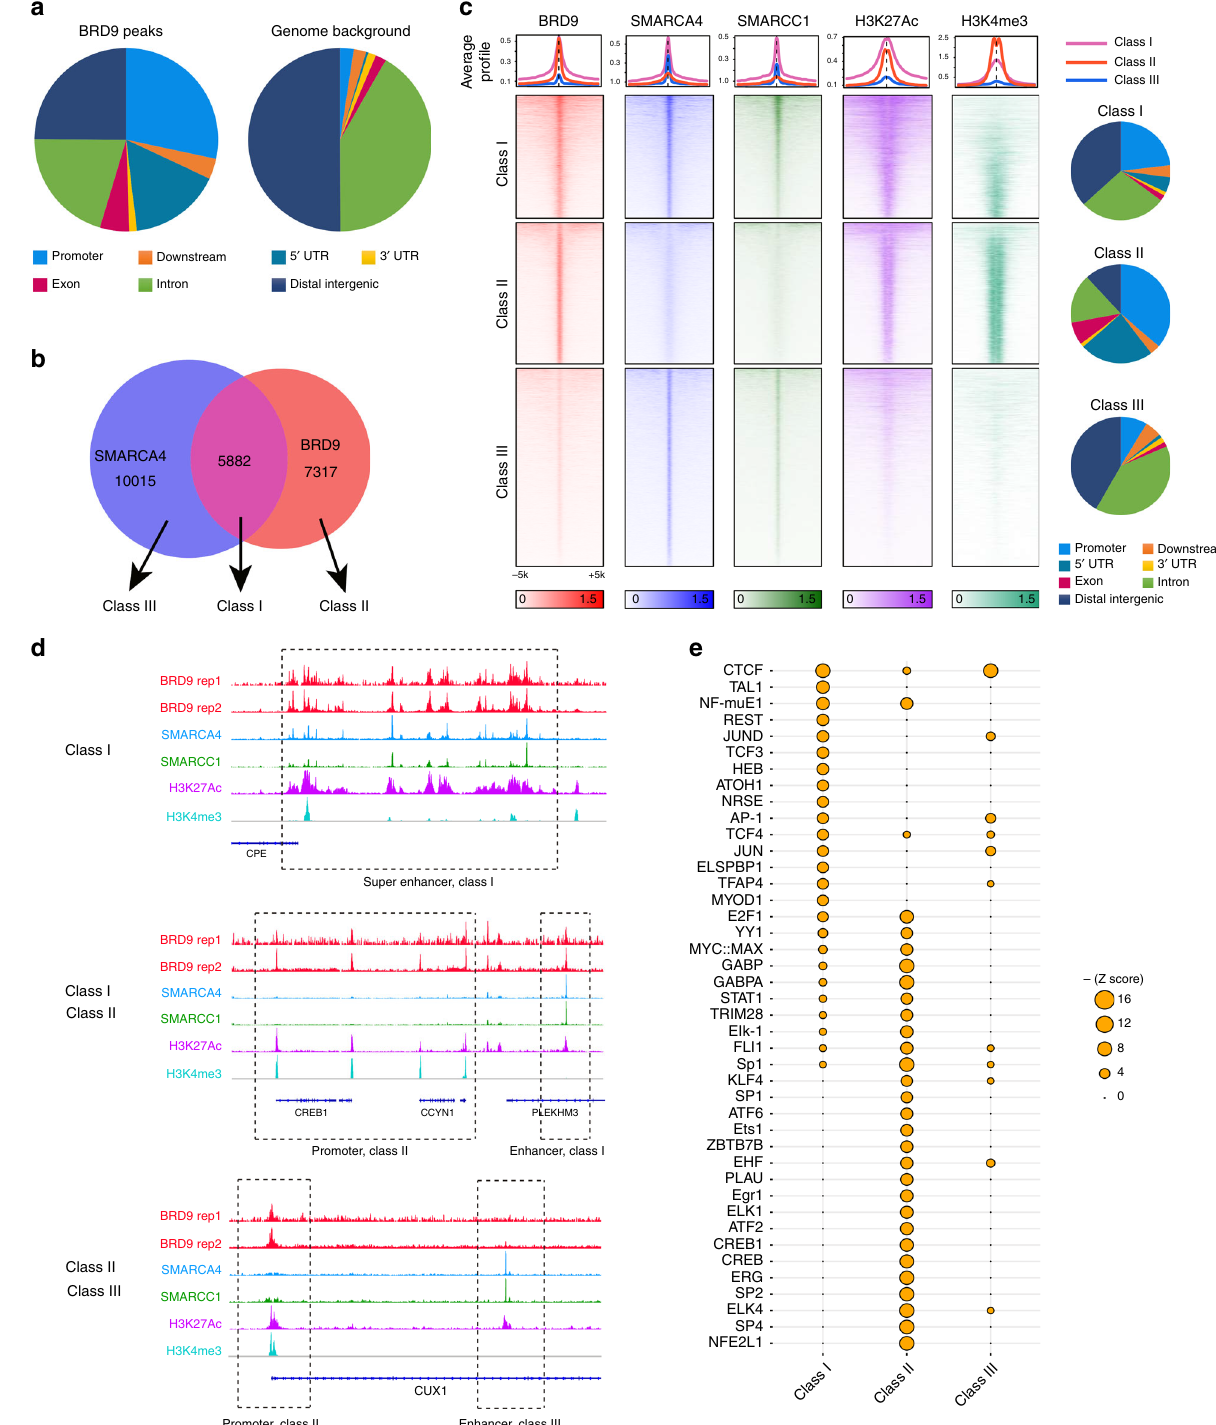
Fig. 4 Genome-wide targeting of BRD9 directly regulates gene expressions. a The genomic distribution of BRD9 binding sites in G401 cells. b Venn diagram of overlap between SMARCA4 and BRD9 peaks and de fi nition of the three classes of BRD9 peaks. c The average ChIP enrichment pro fi le of BRD9, SMARCA4, SMARCC1, H3K27Ac, and H3K4me3 over class I, class II, and class III peak regions (top). Heatmap illustrating the ChIP-seq signal 5 kb up- and downstream of the different peak classes. The genomic distribution of each class is shown in the right. d Examples of BRD9, SMARCA4, SMARCC1, H3K27Ac, and H3K4me3 ChIP-seq at representative Class I, II, and III peak regions. e Comparison of motif enrichment in different peak regions. Size of the circle represents the signi fi cance of the